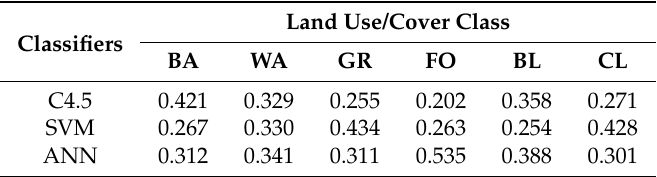
Table 6. The average contribution by each base classifier in MCS_WV for each land use/cover class.